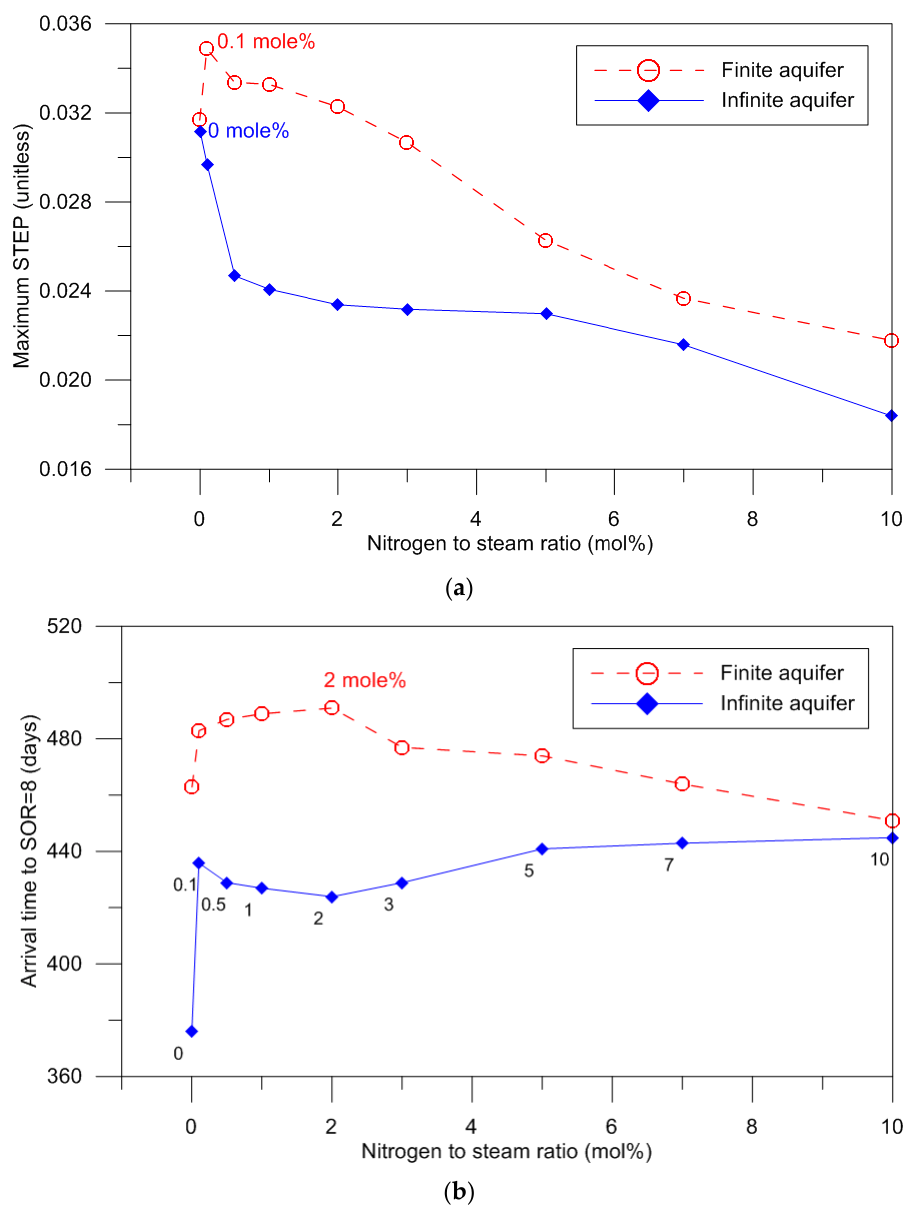
Figure 6. Effects of the nitrogen mole fraction on STEP and the production time with energy efficiency: plot of ( a ) the maximum STEP and ( b ) the arrival time to SOR = 8 vs. the nitrogen to steam ratio at the injector.